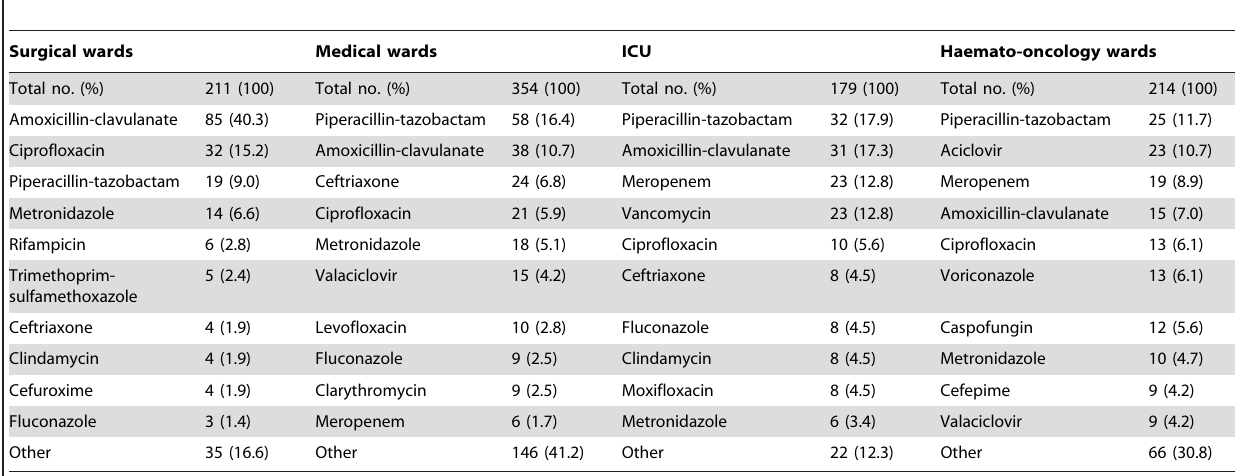
Table 2. Top ten antimicrobial drugs for treatment in different hospital units: No. (%) of prescriptions.